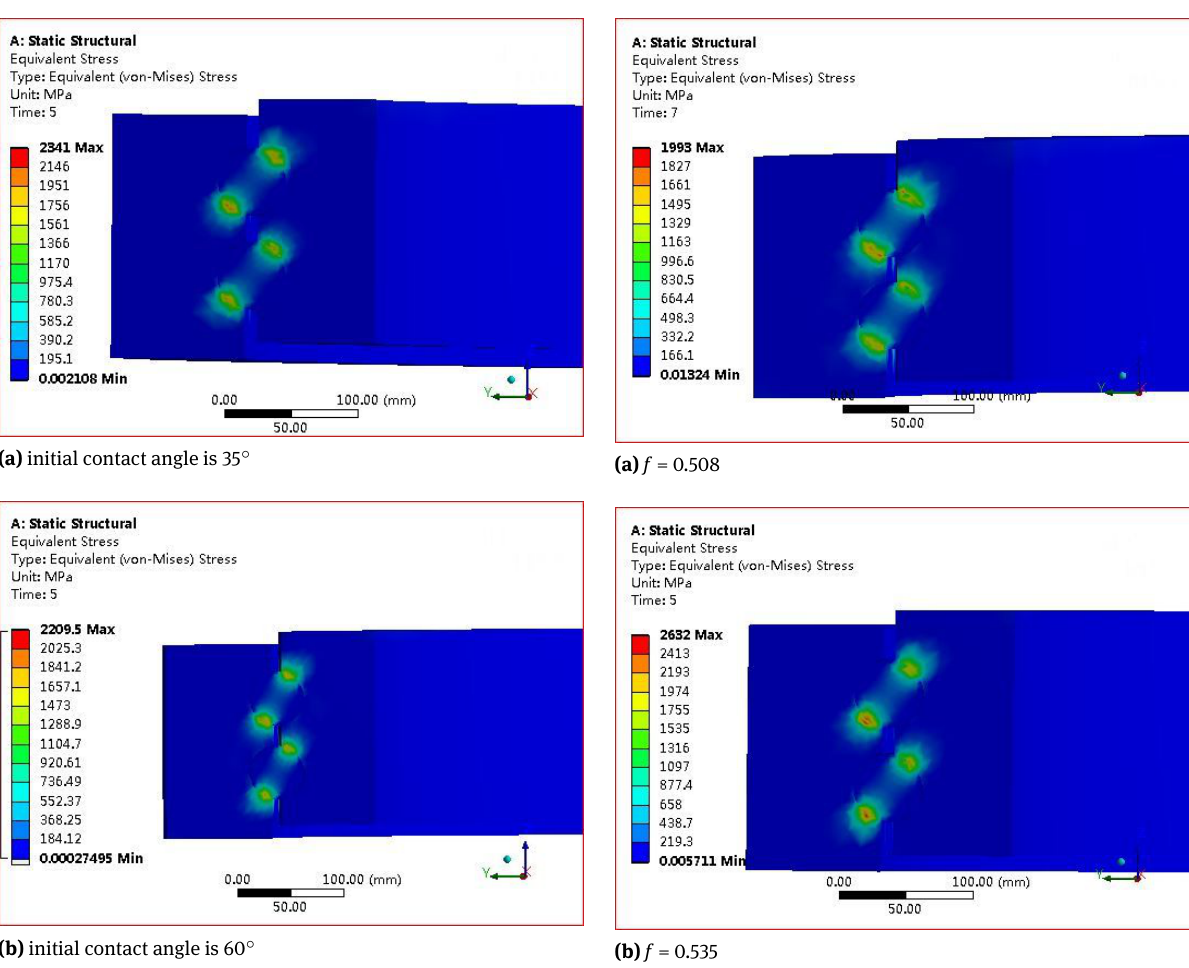
Figure 19: Equivalent stress distribution for different initial contact angle